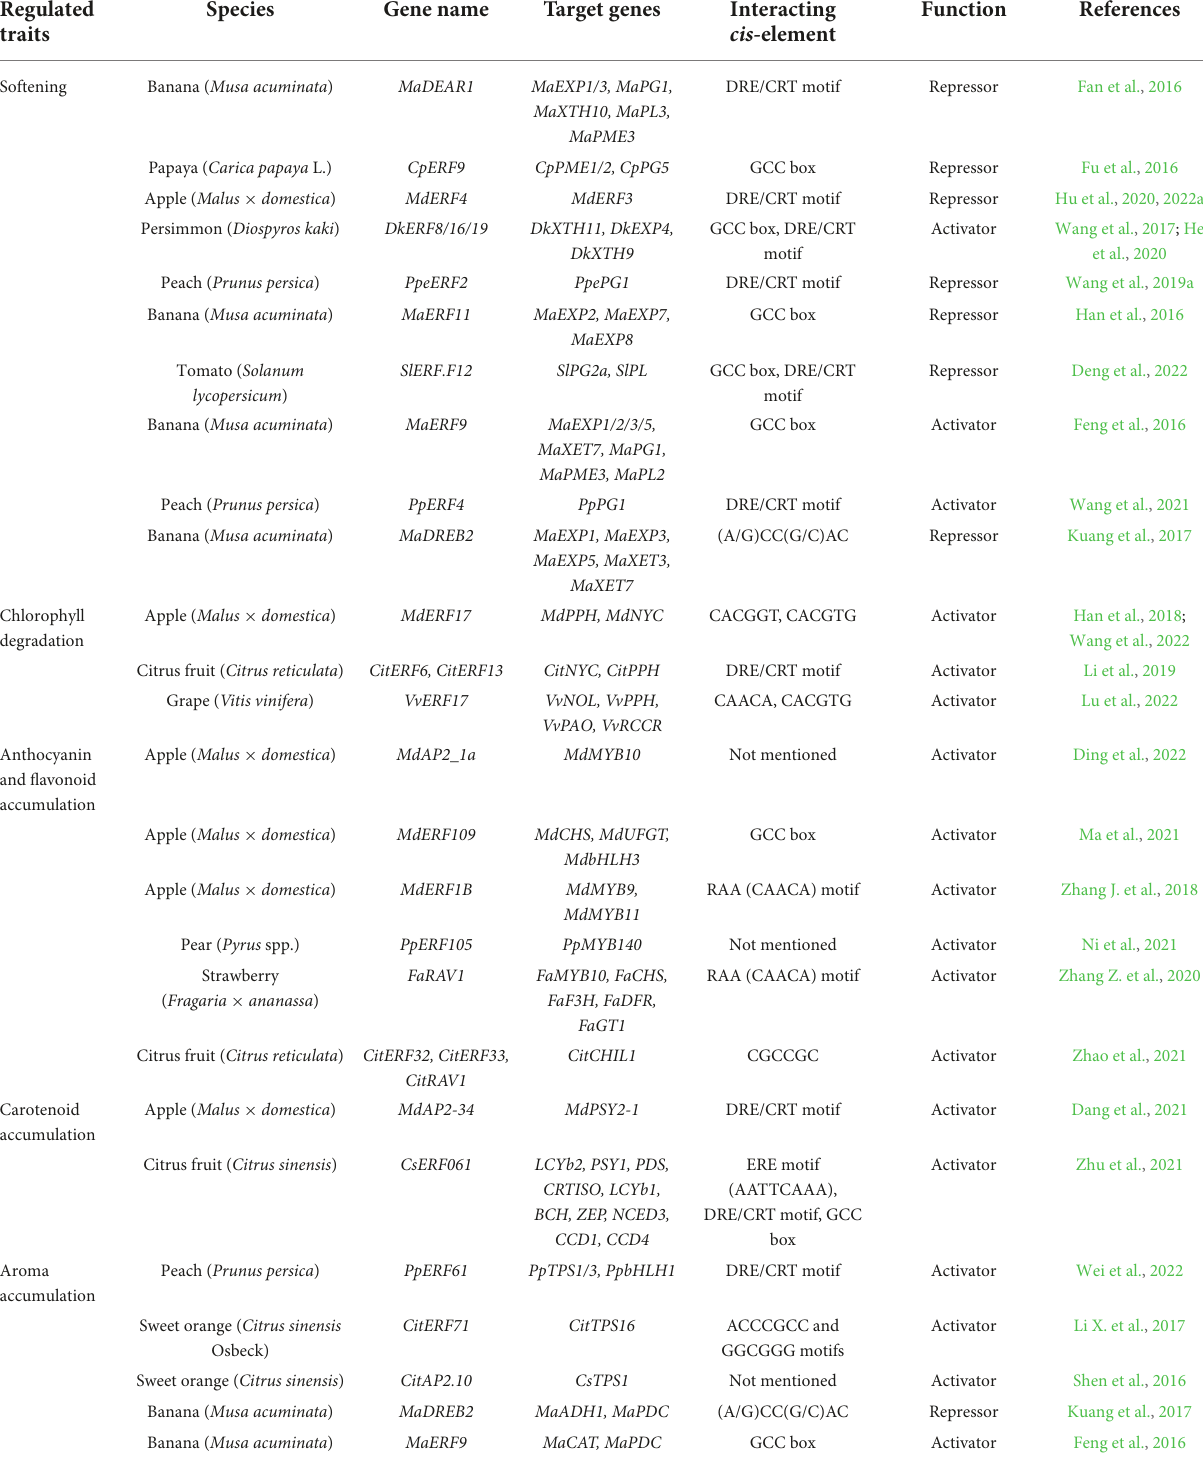
TABLE 1 AP2/ERF regulation of different ripening-related